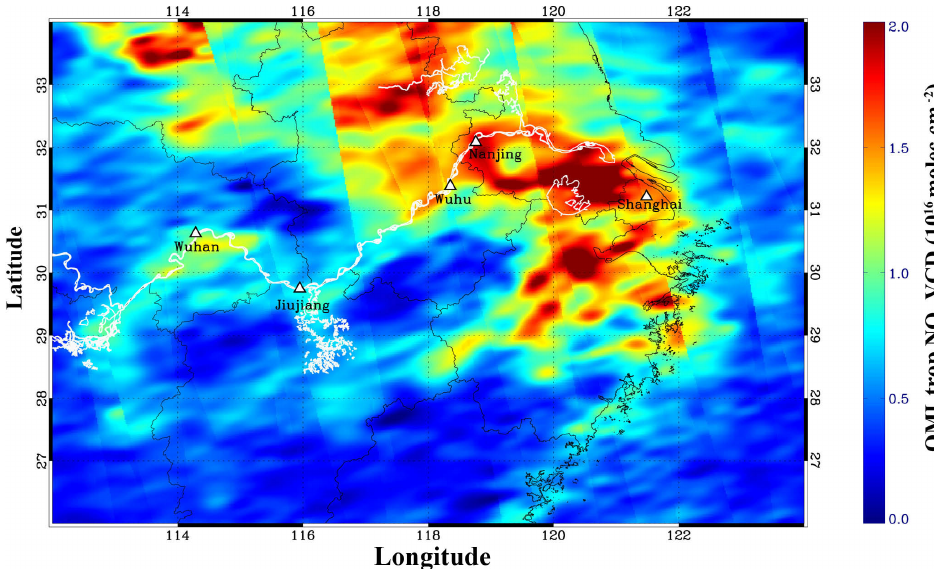
Figure 9. The spatial distribution of averaged tropospheric NO 2 VCDs measured by OMI during the Yangtze River campaign (22 November to 4 December